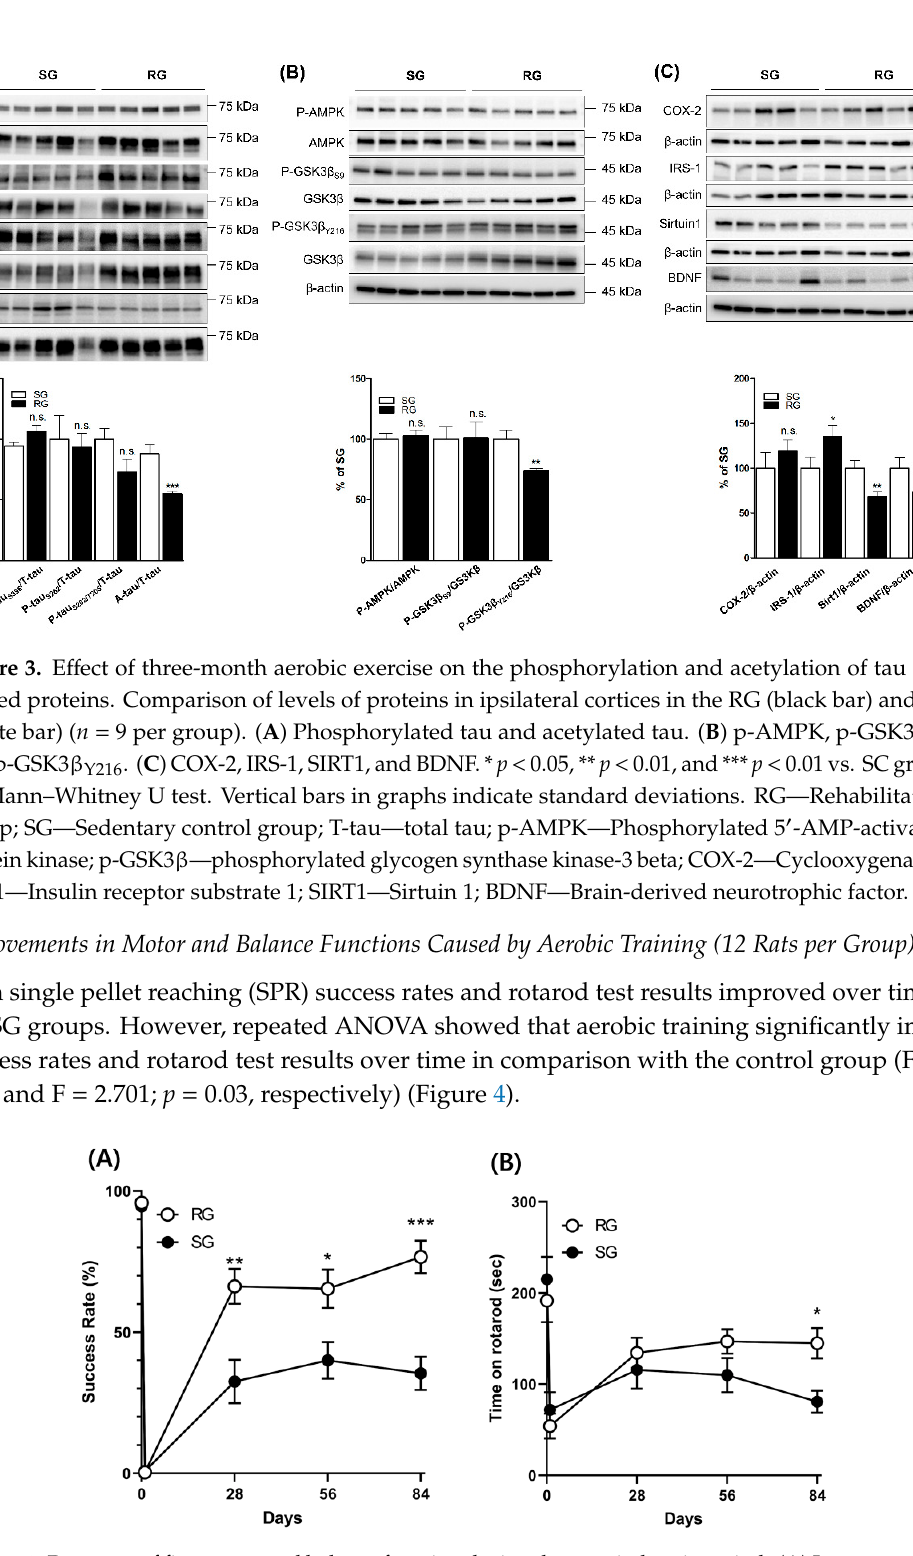
Figure 4. Recovery of fine motor and balance function during the post-ischemic period. ( A ) Improvements in fine motor function as determined by success rates (%) of results of the single pellet reaching (SPR) test ( n = 12 per group; F = 7.875; p = 0.001). ( B ) Improvements in balance function as determined by the rotarod test (F = 2.701; p = 0.03). Vertical bars indicate standard errors. * p < 0.05, ** p < 0.01, and *** p < 0.01 vs. SG group by Mann–Whitney U